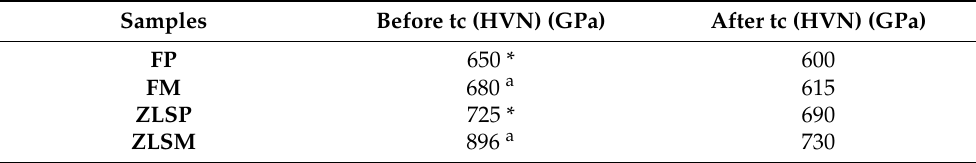
Table 4. Mean values for the microhardness testing. * , a statistically significant.